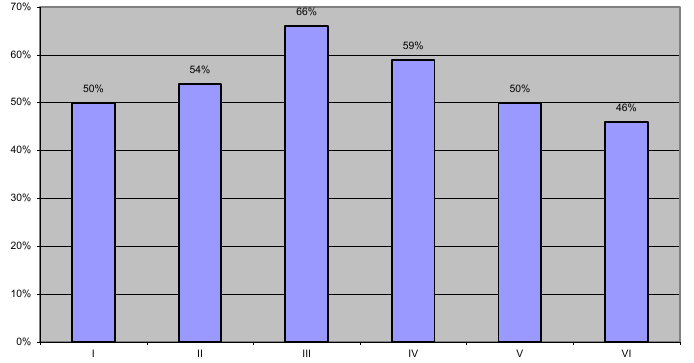
Figure 4. Overall results of the therapeutic potential analysis of the gardens under study.